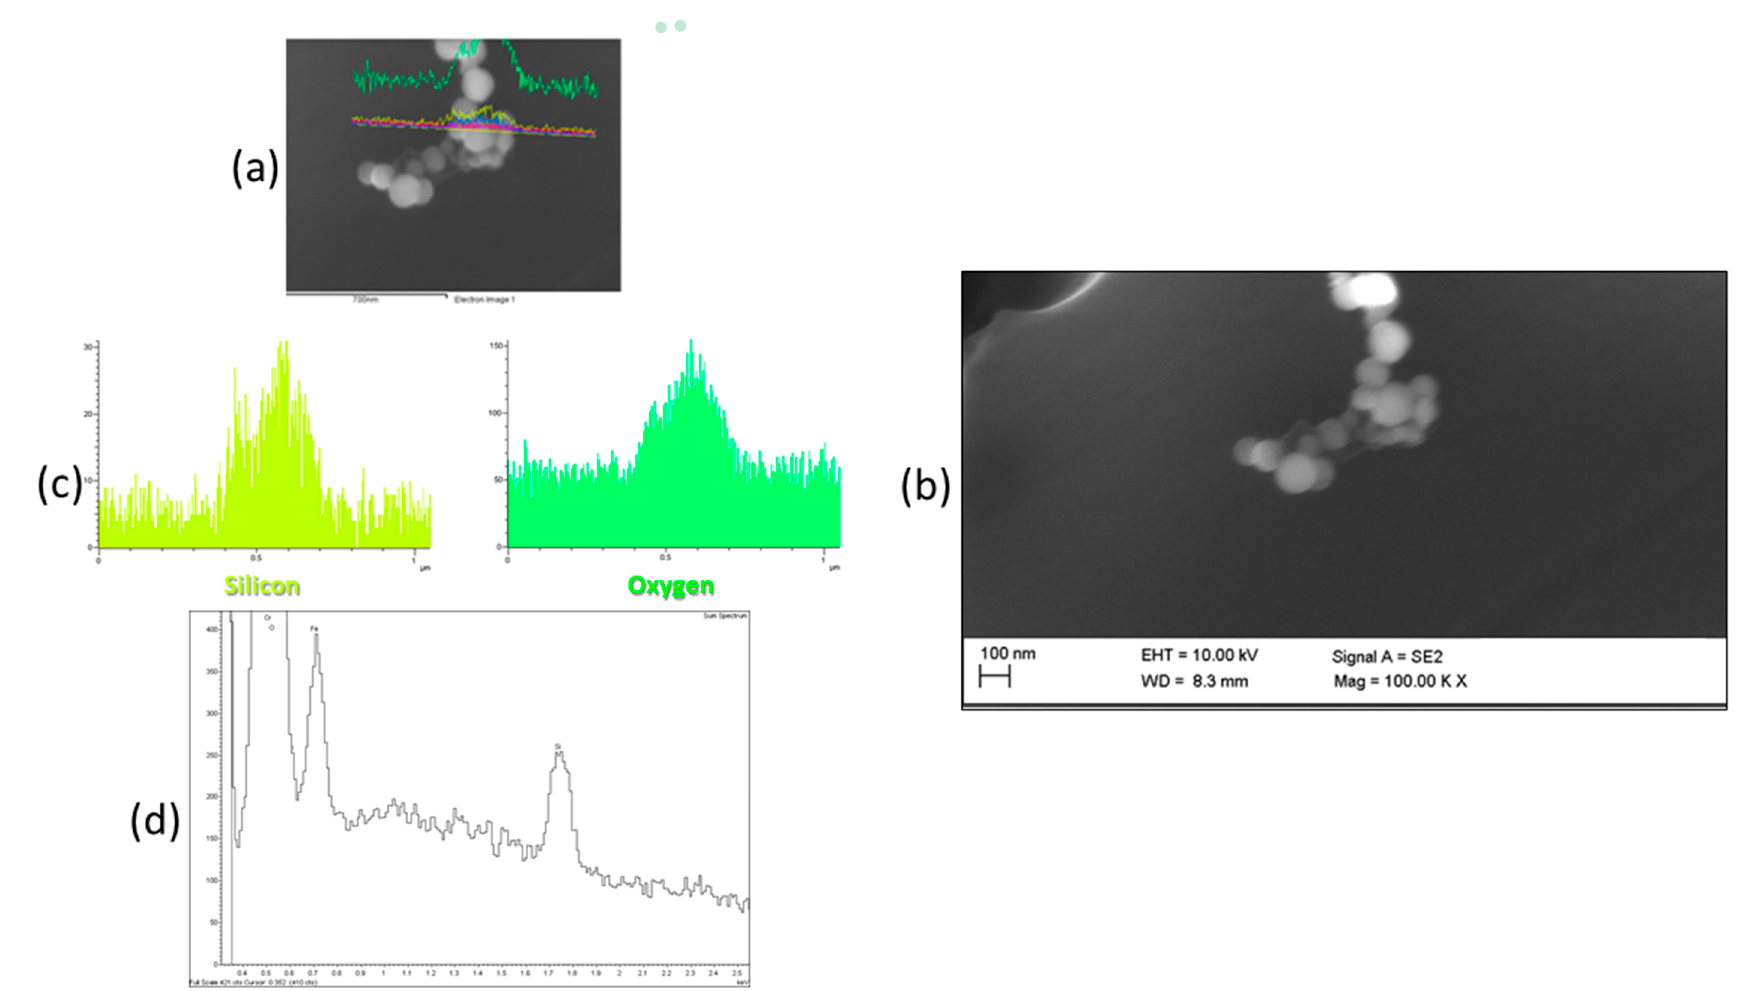
Figure 5. SEM image ( a , b ) and EDS spectrum ( c , d ) of SiO 2 core shell NPs collected by the Sioutas (Stage D: 250–500 nm): Magnification 100 Kx, detector SE2, EHT 10.00 KV, WD 8.3 mm.